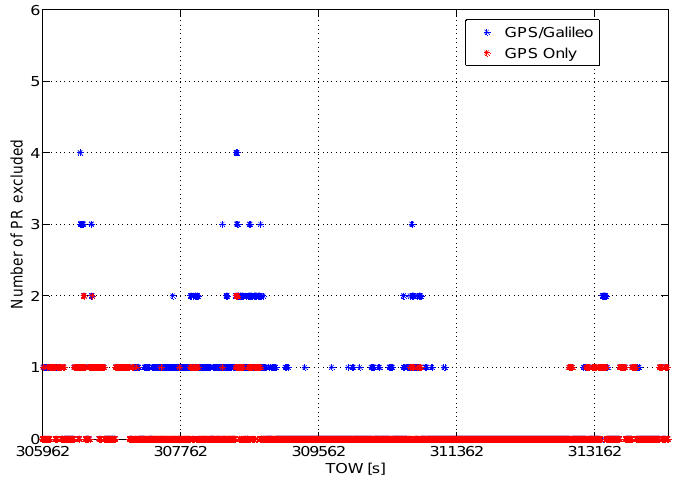
Figure 5. Number of pseudoranges excluded epoch by epoch. More exclusions can be performed when the multi-constellation approach is